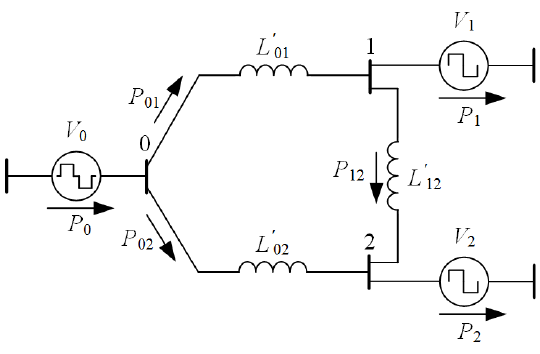
Figure 4. Equivalent circuit for the TAB